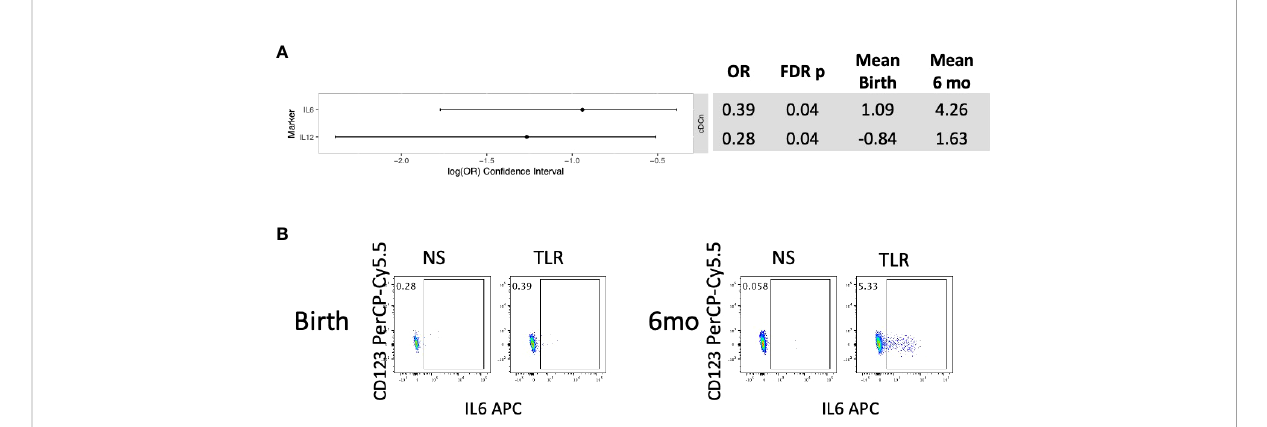
FIGURE 3 Differential functional characteristics of APC in HEU between birth and 6 months of life. Data were derived from 24 HEU at birth and 28 HEU at 6 months. (A) Forest plot and summary statistics of signi fi cant differences. (B) Representative scatter plots of IL6+ cDCn (Lin-HLADR+CD14- CD123-CD1c-) illustrating differences between HEU and HUU at birth and 6 months of